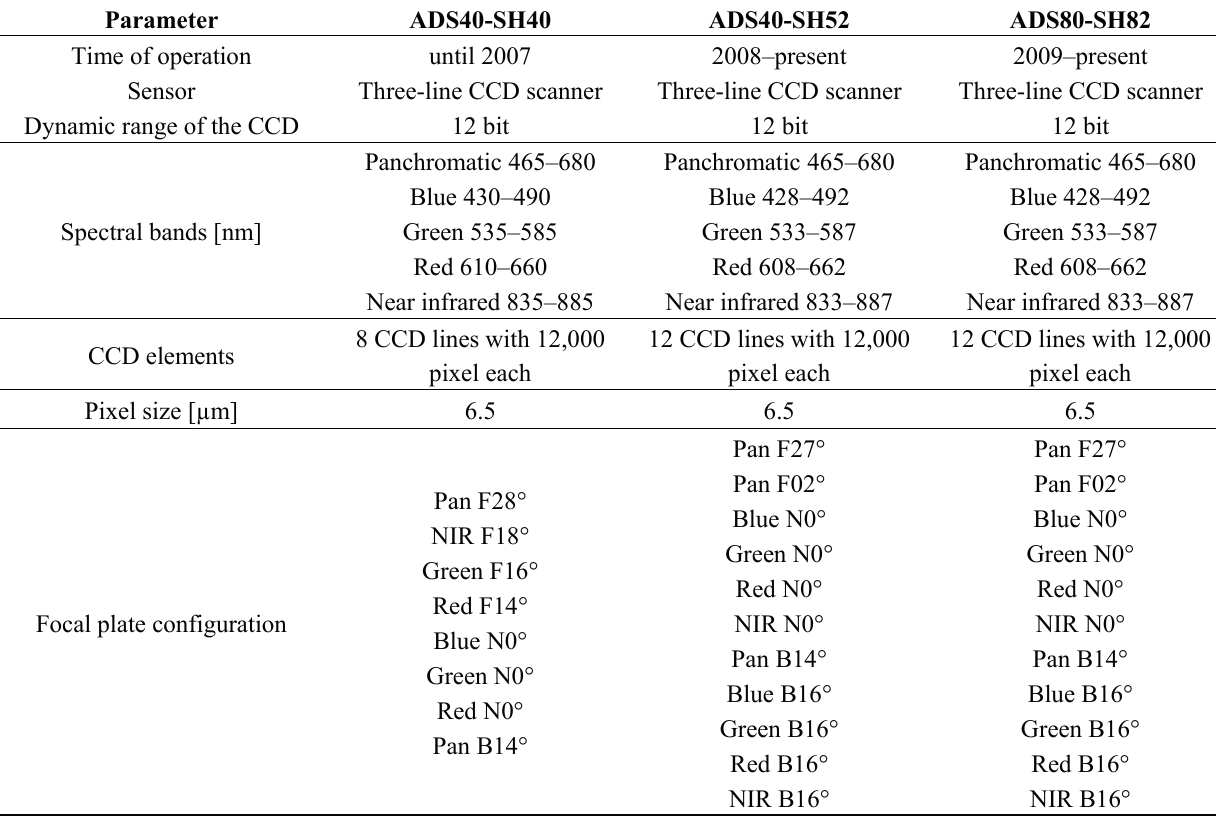
Table A1. Technical details of the Advanced Digital Sensors (ADS) used.